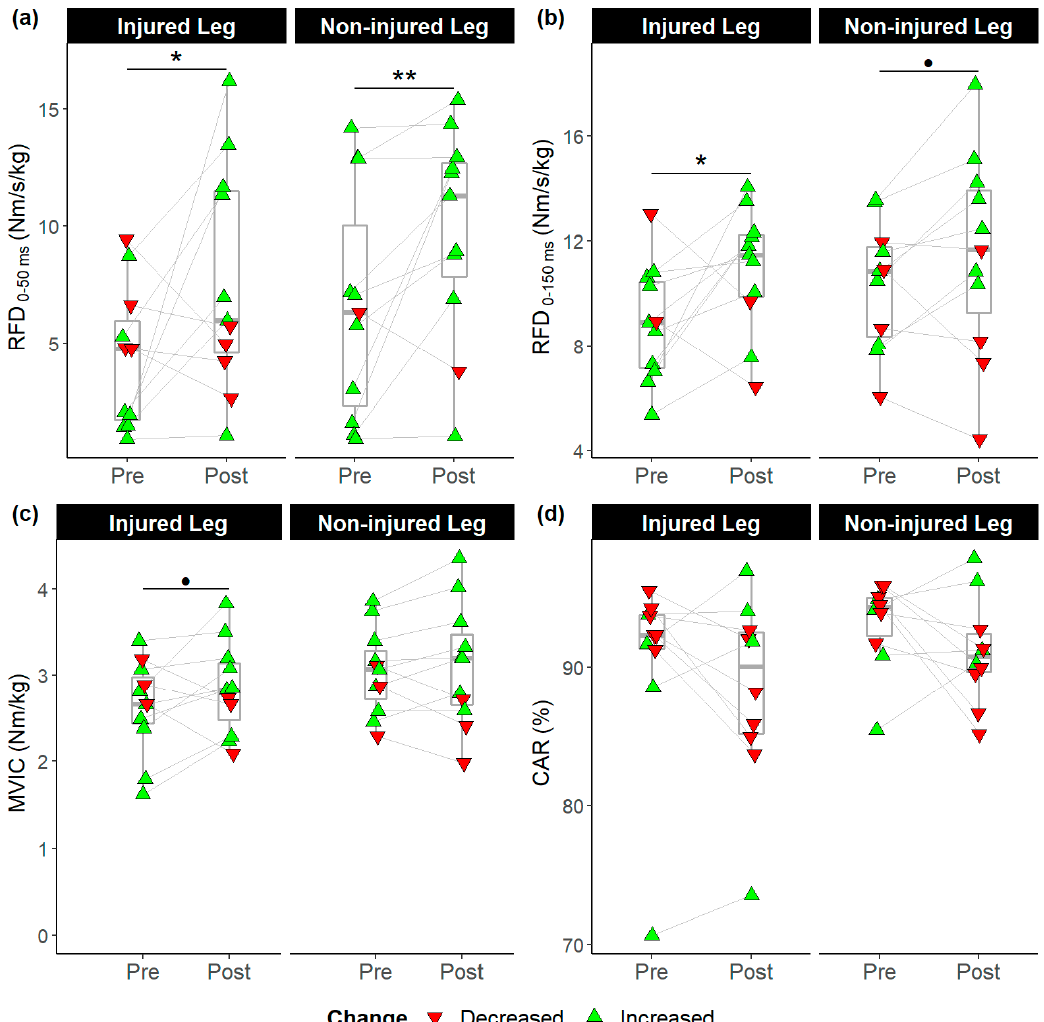
Figure 3. Pre- and post-intervention measures. ( a ) Rate of force development from 0 to 50 ms (RFD 0– 50 ms ); ( b ) Rate of force development from 0 to 150 ms (RFD 0–150 ms ); ( c ) Maximum voluntary isometric contraction strength (MVIC), ( d ) Central activation ratio (CAR); ● : p ≤ 0.10, *: p ≤ 0.05, **: p ≤ 0.01. Green triangles indicate participants who improved after intervention; red triangles indicate participants who did not.